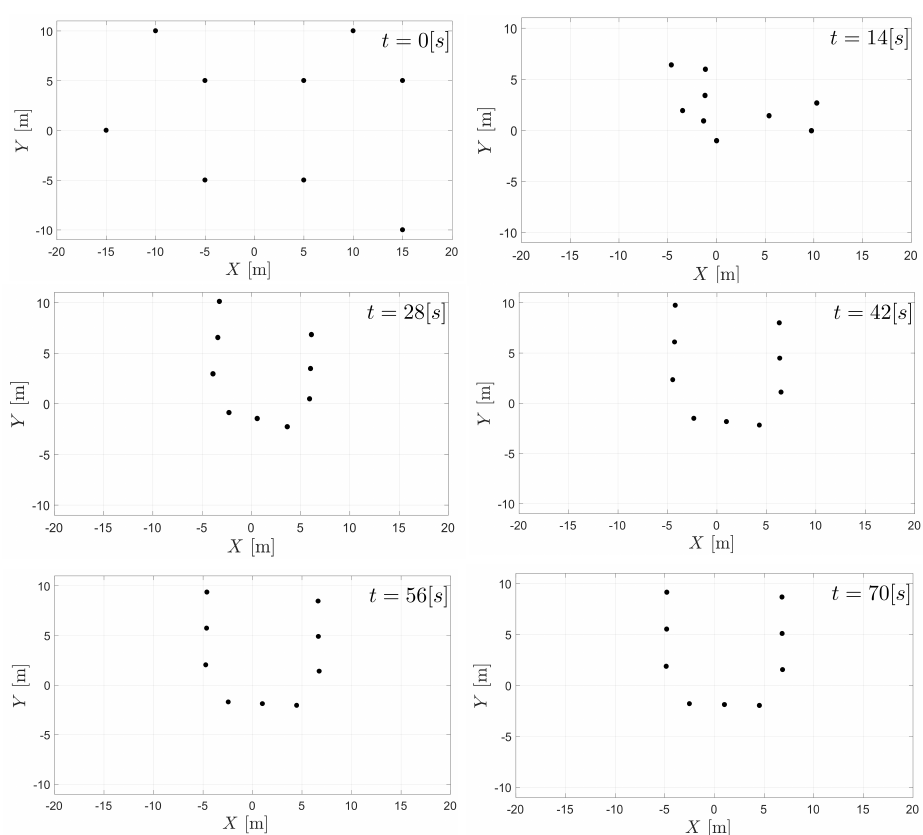
Figure 9. Spatial distribution of agents at some specific